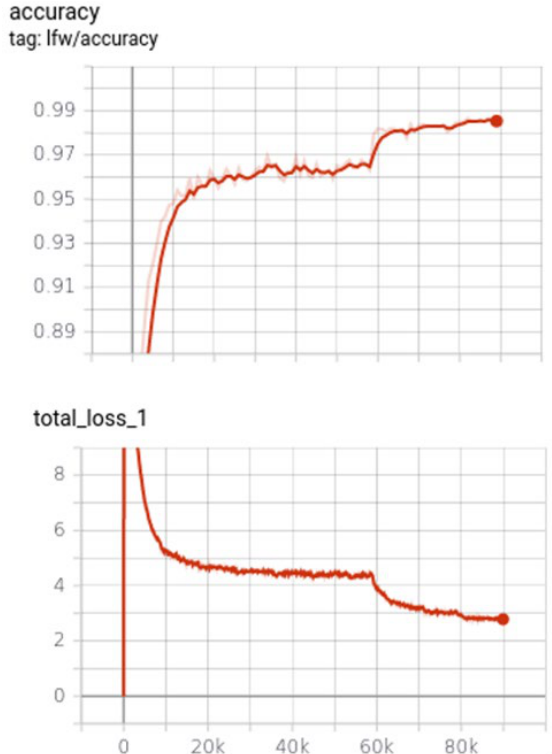
Figure 3. Our face recognition model was trained with 90 epochs in LFW dataset using different learning rates, showing the accuracy curves and loss curves in the training stage.